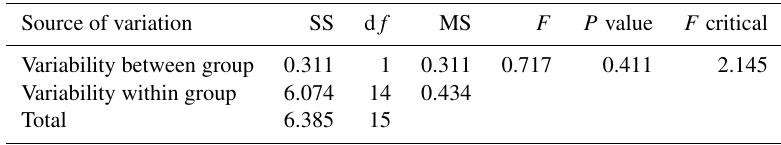
Table 3. ANOVA results of LAI determination with grass height and RapidEye from May to December 2011. Source of